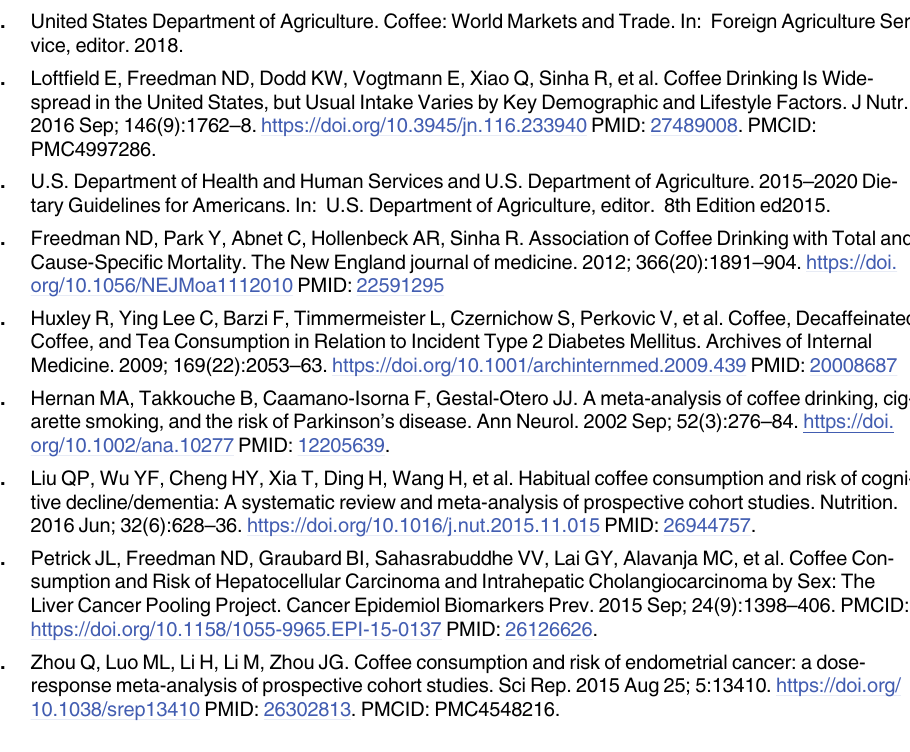
S2 Table. Participant characteristics according to level of coffee intake. S3 Table. Stratified odds of long RTL associated with coffee consumption in the prostate control